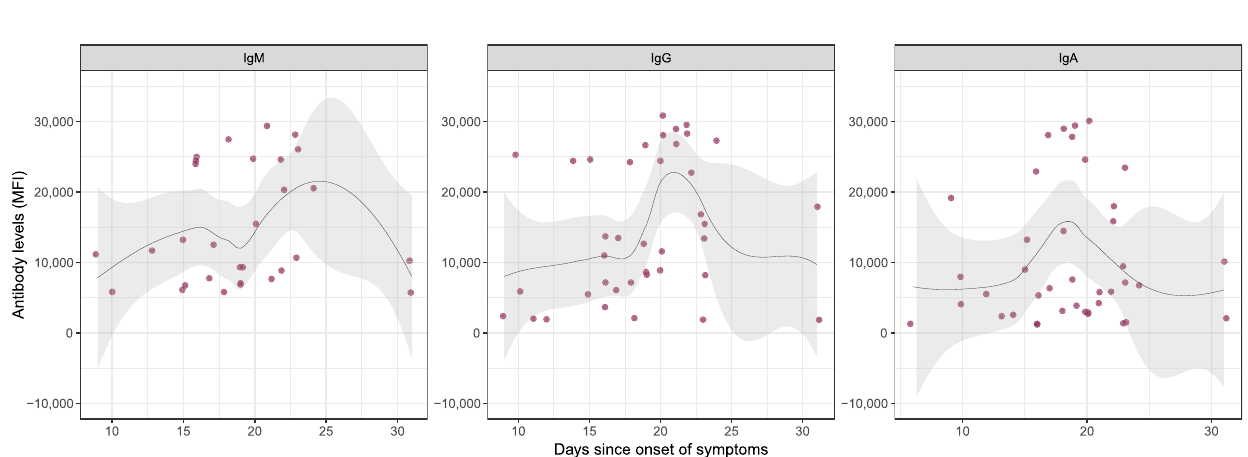
Fig. 4 SARS-CoV-2 antibody levels by time since onset of symptoms in seropositive subjects. Levels (median fl uorescence intensity, MFI) of IgM, IgG, and IgA against Receptor Binding Domain of the SARS-CoV-2 Spike glycoprotein by days since onset of any symptom. Data are shown only for seropositive subjects with any symptom compatible with COVID-19 ( n = 30 for IgM, 39 for IgG, and 40 for IgA). The fi tting curve was calculated using the LOESS (locally estimated scatterplot smoothing) method. Shaded areas represent 95% con fi dent intervals. One subject seropositive for the three isotypes and who started symptoms 40 days before serological testing is not Methods Study design, population and setting . The study design consists of four cross- sectional surveys (at baseline, 1 month, 6 months and 12 months) in the same cohort of randomly selected HCW from HCB. We hereby present the fi rst cross- sectional survey, conducted from March 28th to April 9th, 2020. The study population was de fi ned as those who deliver care and services to patients, either directly as physicians or nurses, or indirectly as assistants, technicians, stretcher- bearers, or other support staff (administrative of fi cers, cleaning, kitchen, laundry, maintenance, etc.) 29 . Inclusion criteria included being an adult (>17 years) worker at HCB registered at the Human Resources department. Exclusion criteria inclu- ded: (a) absenteeism from workplace in the last 30 days (i.e., on vacation, sick leave, sabbatical), (b) working exclusively outside the HCB or Maternity main buildings with no interaction with patients on a daily basis, (c) retirement or end-of-contract planned within one year after the recruitment date, and (d) participating in COVID-19 clinical trials for preventive or treatment therapies. HCB is a large University of Barcelona teaching hospital. With over 700 beds, it is the main public supplier of specialized health services for a population of around 540,000 inhabitants and also acts as a tertiary referral hospital 30 .